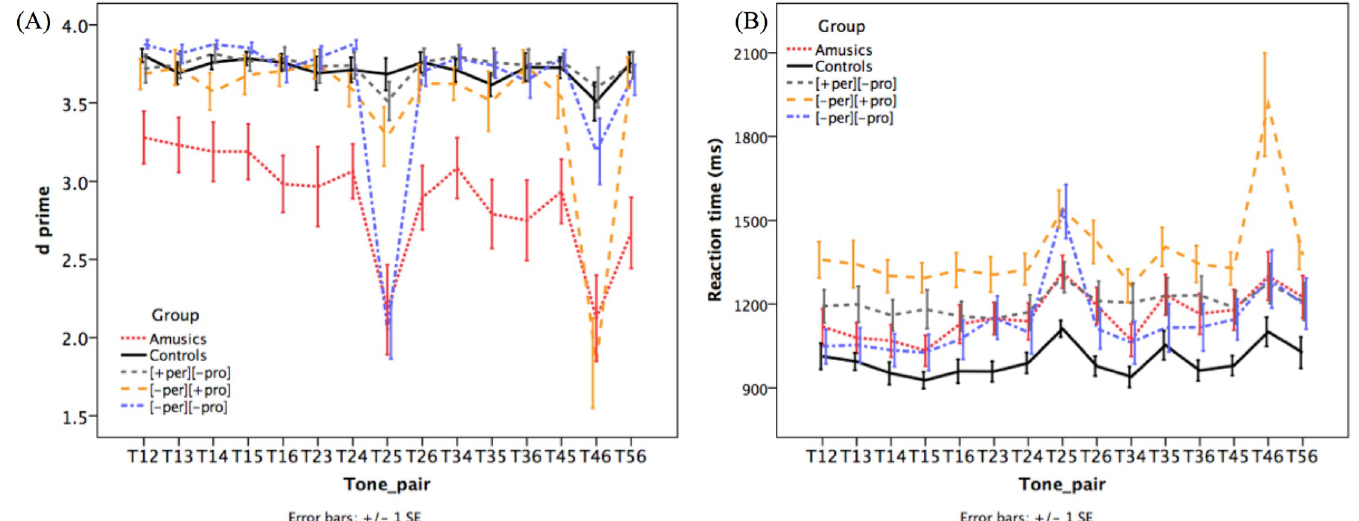
Fig 6. The d’ scores (A) and reaction time (B) of 15 tone pairs in the tone discrimination task by the five groups (Error bar = ± 1 SE). [+per][-pro]: T2-T5; [-per][+pro]: T4-T6; [-per][-pro]: T2-T5. https://doi.org/10.1371/journal.pone.0253982.g006 [+pro] group was less sensitive to only T4-T6 than the controls ( p = .006), while their sensitiv- ity to other tone pairs were comparable. Similarly, the [-per][-pro] group was less sensitive to only T2-T5 than the controls ( p < .001), while being comparably sensitive to other tone pairs. On the contrary, the [+per][-pro] group performed comparably to the controls in all tone pairs, with no significant difference in any tone pair. The perceptual confusion patterns reported above match the defining characteristics of each tone-merging group.